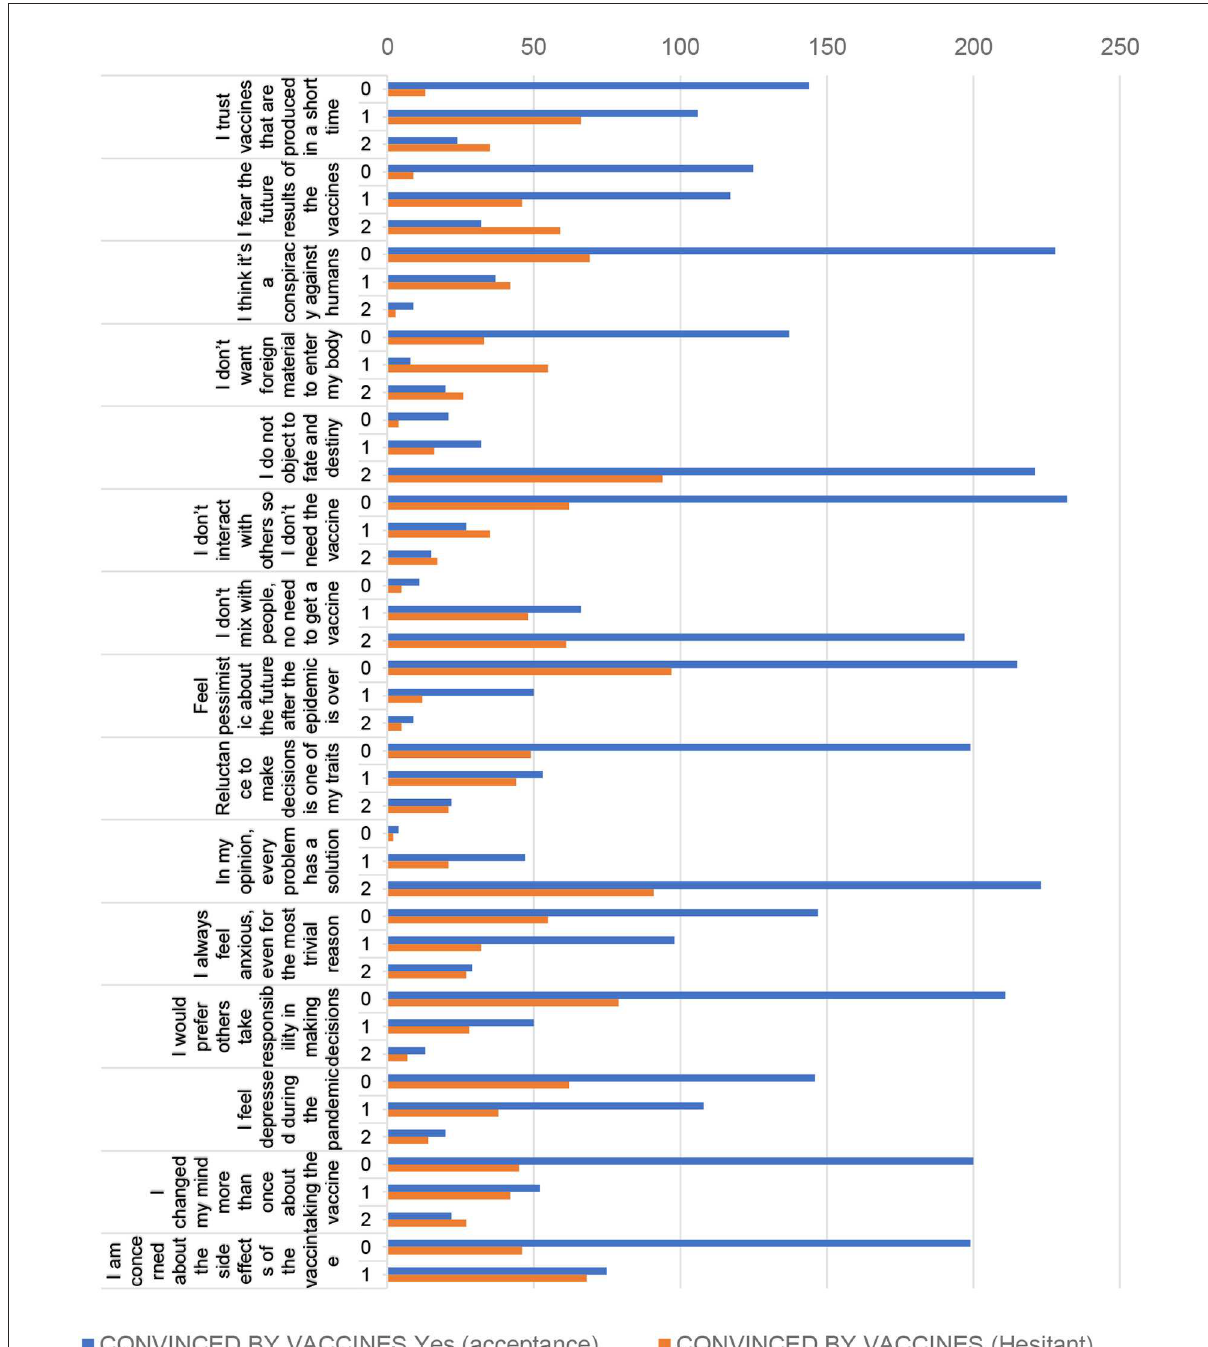
FIGURE2 The frequency distribution and chi-squared analysis of the influence of personal characteristics and vaccine confidence. 0 = Do not agree, 1 = Somewhat agree, 2 = Agree.